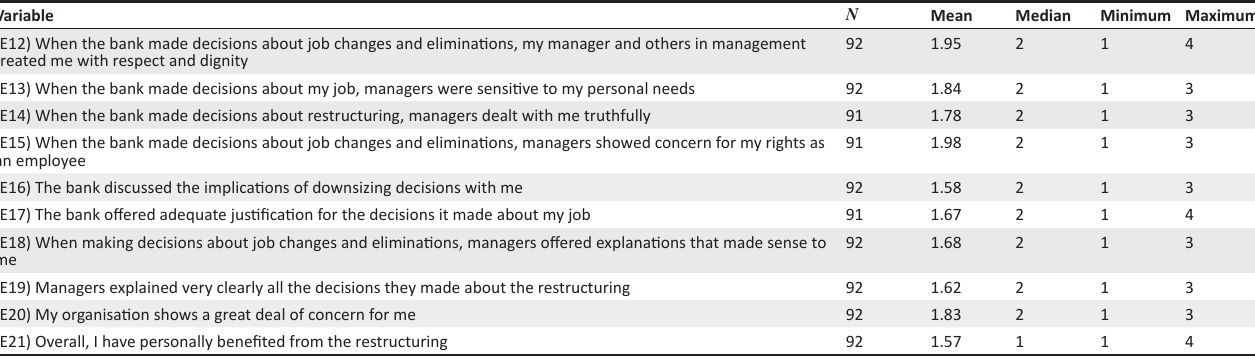
TABLE 5: Descriptive statistics for survivors’ perceptions of procedural and interactional fairness when downsizing (section E).